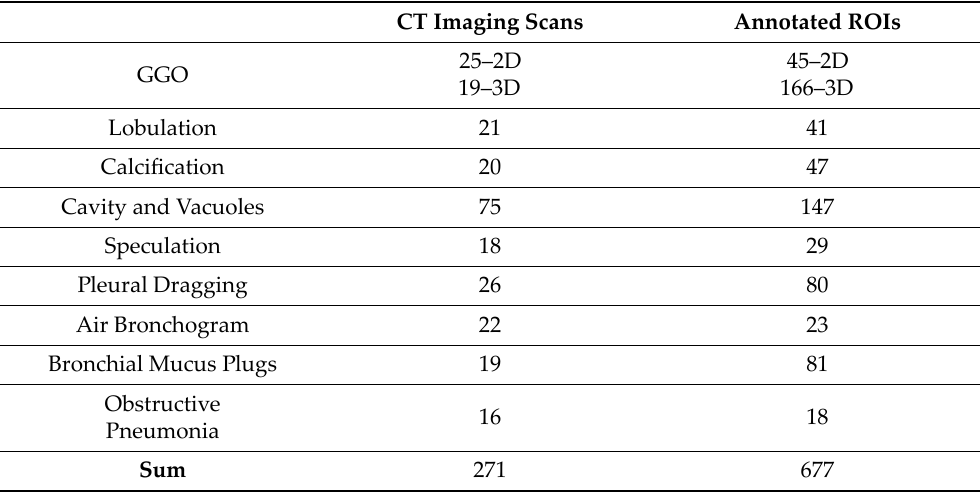
Table 5. Dataset